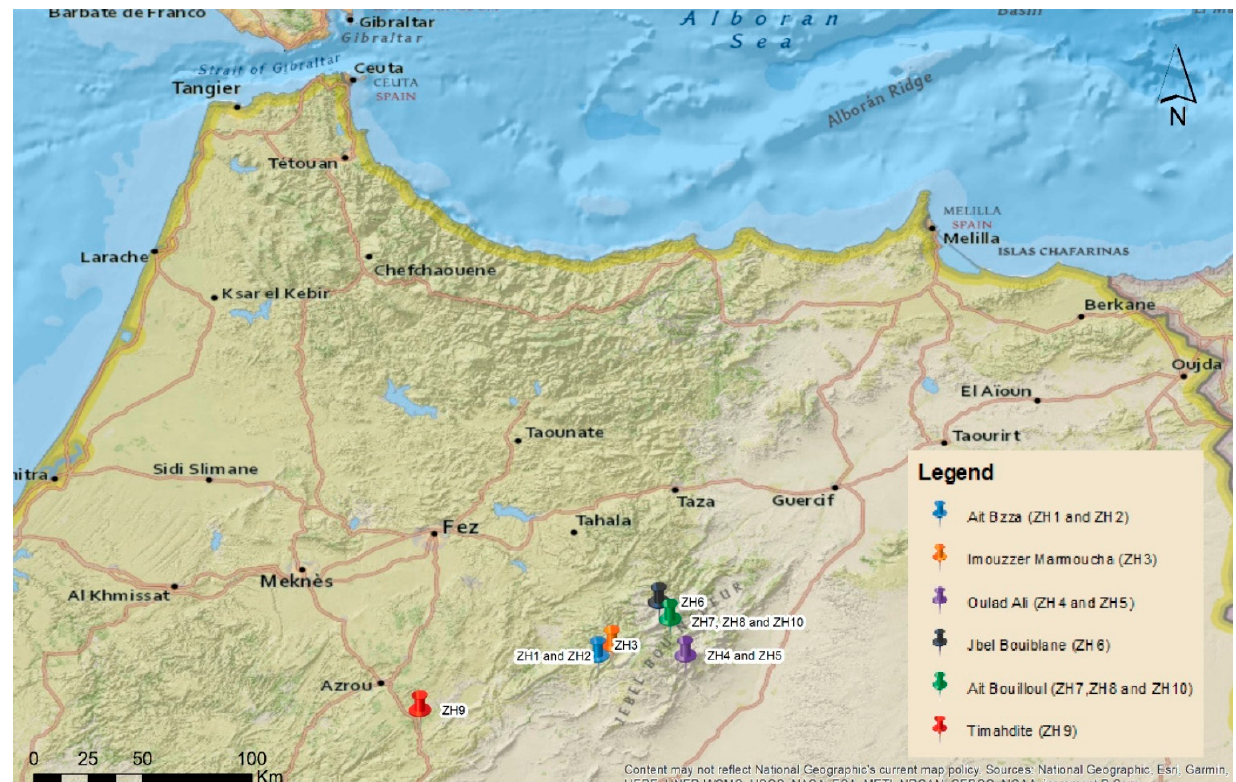
Figure 1. Study area map including the geographic sampling distribution.